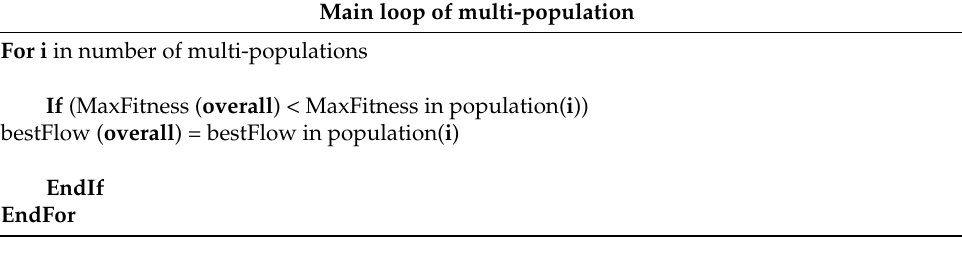
Table 5. Multi group strategy pseudo